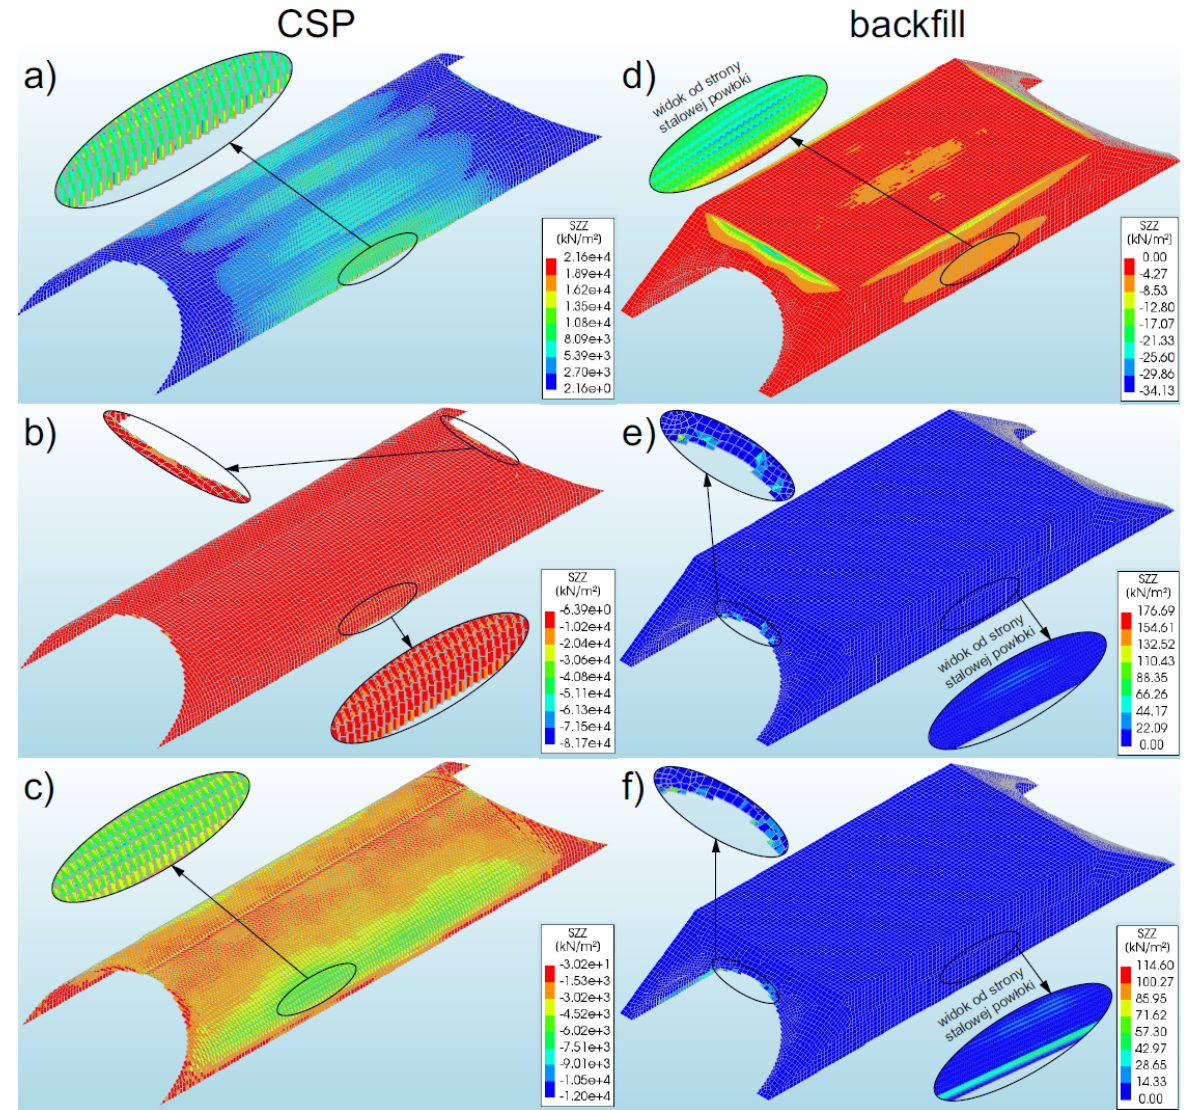
Figure 14. View of the maximum global stresses (in Z direction) for bridge #I in the steel shell and backfill for model 1 ( a , d ), model 2 ( b , e ), and model 3 ( c , f ).